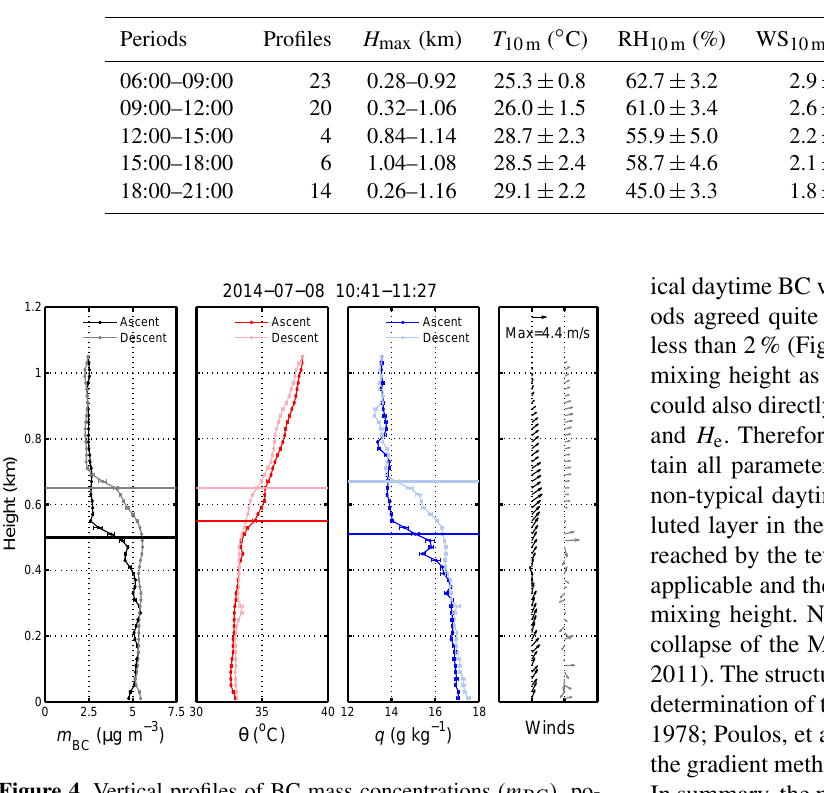
Figure 4. Vertical profiles of BC mass concentrations ( m BC ) , po- tential temperature ( θ) , specific humidity ( q) , and winds on 8 July 2014 (10:41–11:27LT). Profiles measured during the ascent are dis- played in dark colors, while those during the descent are displayed in light colors. Dots indicate 20m averaged data, with standard de- viations in error bars. Heights of the mixing layer (ML) estimated from vertical profiles are given in horizontal lines. Arrows show vector mean horizontal winds, with northerly winds indicated by downward arrows. The wind vector for the maximum wind speed is marked by the text